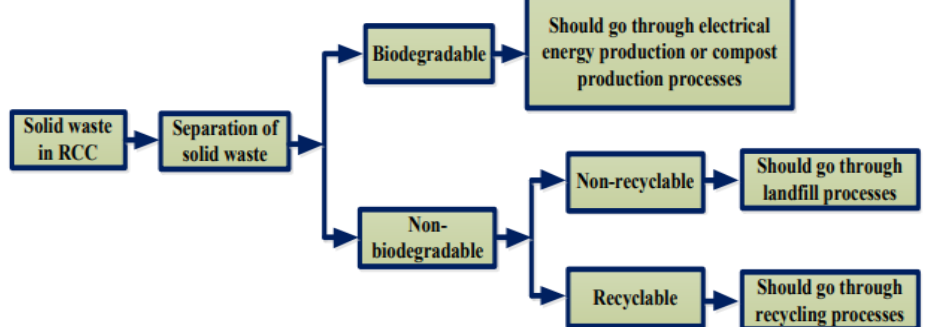
Figure 6: Proposed waste management system for Rajshahi city